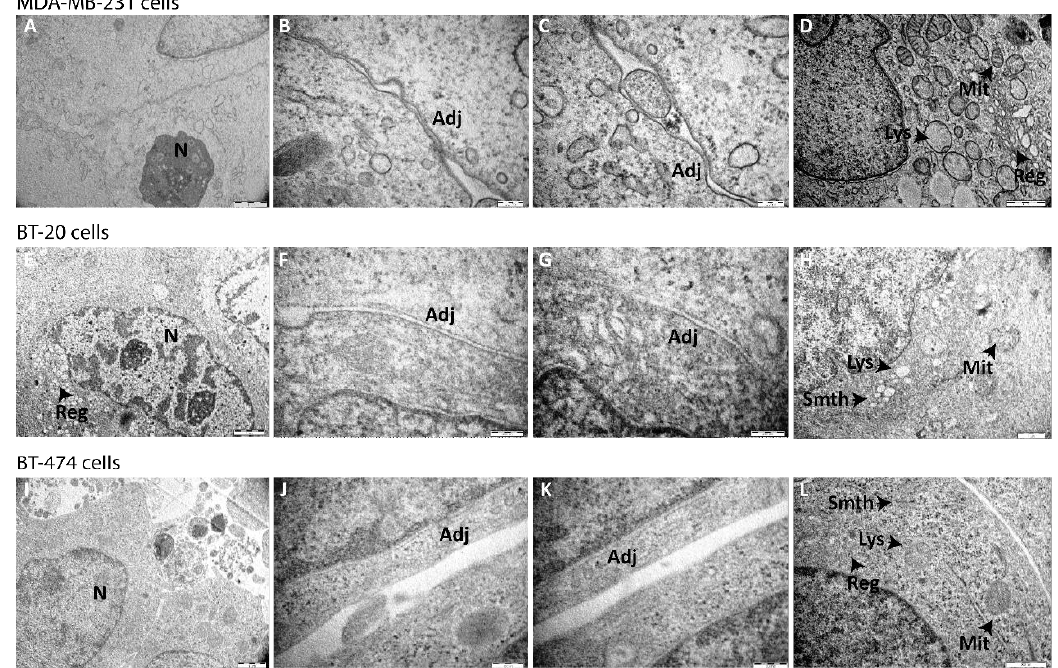
Figure 4. Ultrastructure of MDA-MB-231, BT-20, and BT-474 spheroids by transmission electron microscopy (TEM). Images of ( A – D ) MDA-MB-231, ( E – H ) BT-20, and ( I – L ) BT-474 spheroids formed under optimized conditions were acquired after 7 days of culture with TEM microscope Hitachi H-7000. Scale bars are shown on all images. N = nucleus; Adj = adjoined connections; Mit = mitochondria; Lys = lysosome; Reg = rough endoplasmic reticulum; Smth = smooth endoplasmic reticulum.